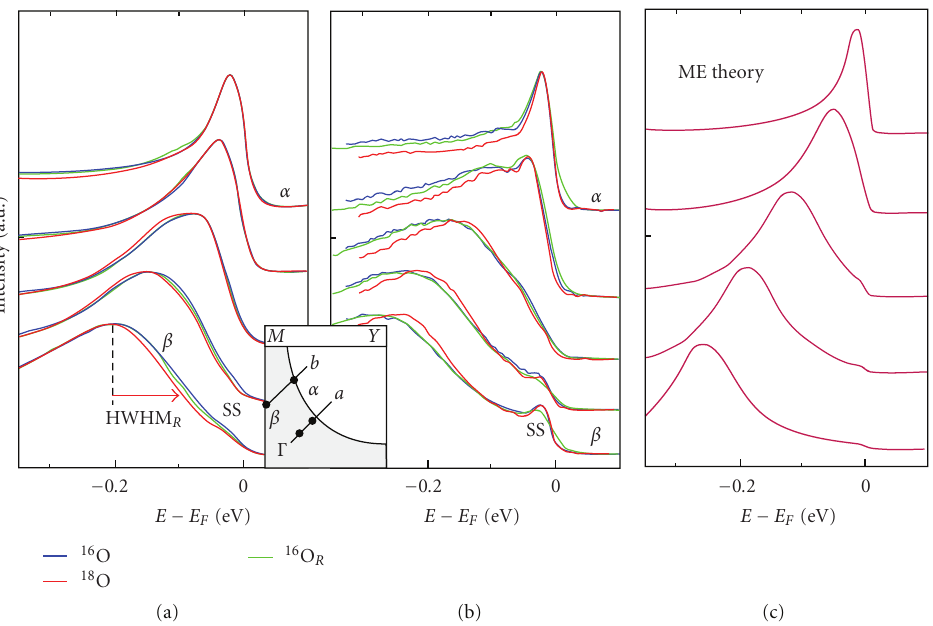
Figure 13: (a-b) Comparison of ARPES EDCs for the three samples from Figure 6(c), each normalized to same peak height. The cuts a and b for each panel, respectively, are indicated in the inset spanning the two panels along with the approximate location along the cut in k -space for the EDCs. (c) Migdal-Eliashberg (ME) simulations for the expected change to (a) and (b) from ME for 16 O and 18 O, under-predicting the observed IE as described in text. The figures are from